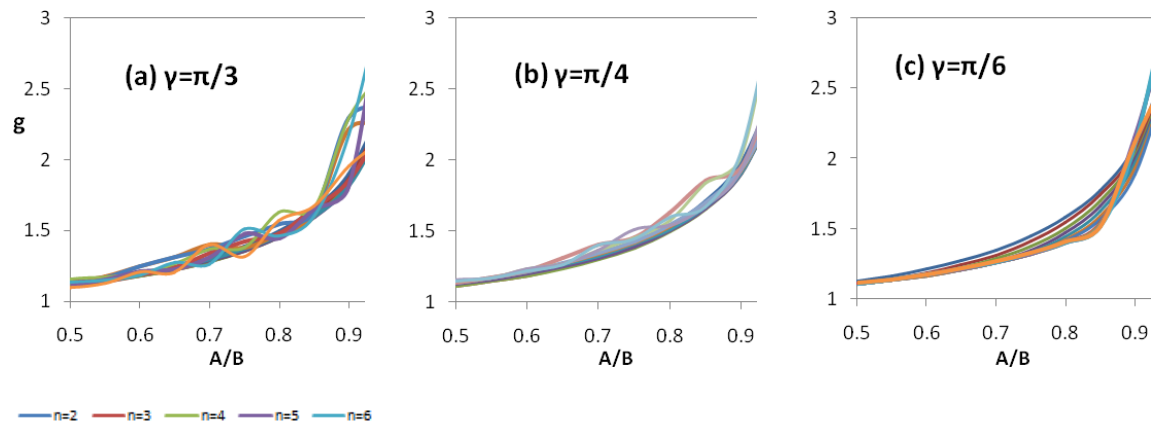
Figure 5: Buckling of confined tube–fixed outer boundary condition. One layer model with growth. µ =5kPa, k 1 =1, k 2 =0.2. Critical isotropic growth rate (g1=g2) plotted tube thickness A/B for various buckling